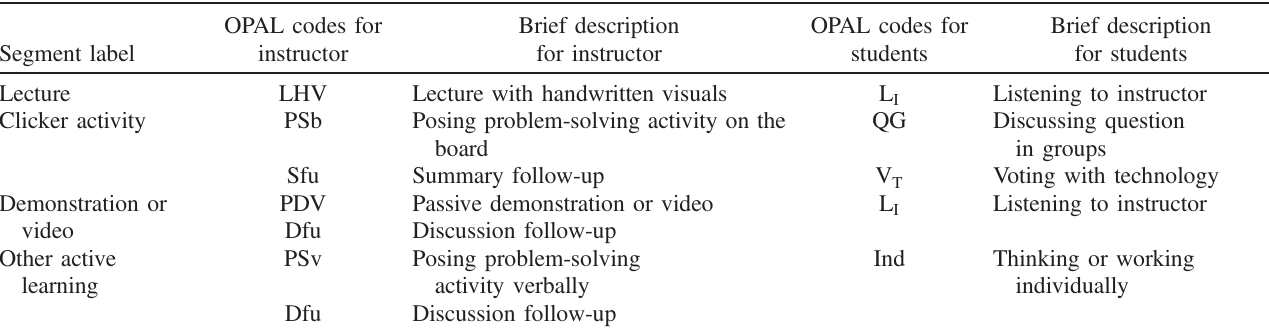
TABLE I. Example OPAL codes in each segment type * . Segment